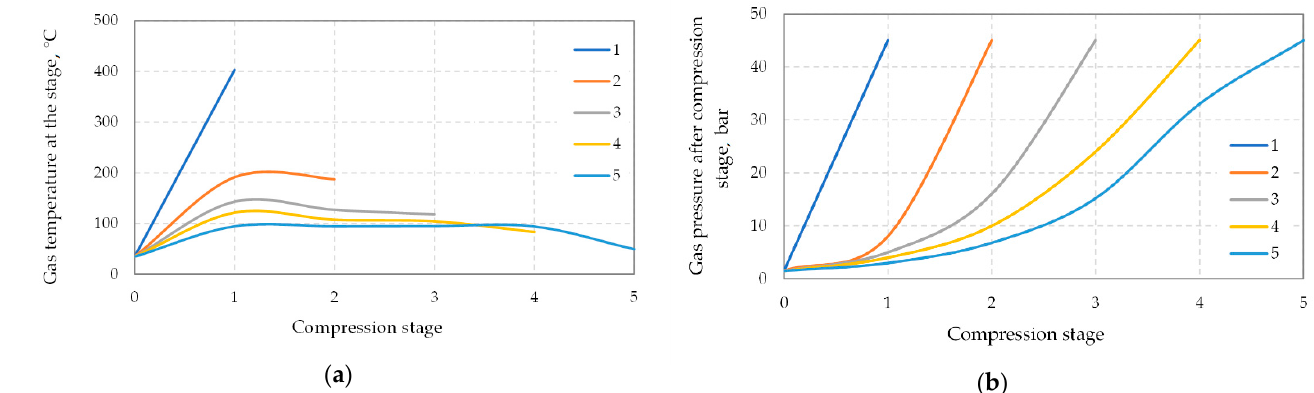
Figure 7. Pressure ( a ) and temperature ( b ) distributions for successive groups of compression stages. The application of multistage compression with interstage cooling results in a decrease in the efficiency of the power unit by approximately 6.5% in the optimistic variant, which translates into a decrease in the net efficiency of electricity generation at the level of 39% (currently constructed power units show a net efficiency of more than 45%) [26]. Therefore, recover heat and increase the efficiency of power